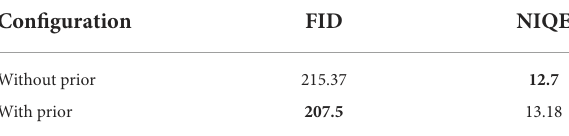
TABLE 1 Quantitative comparison of visual quality improvement by imposing the Laplacian